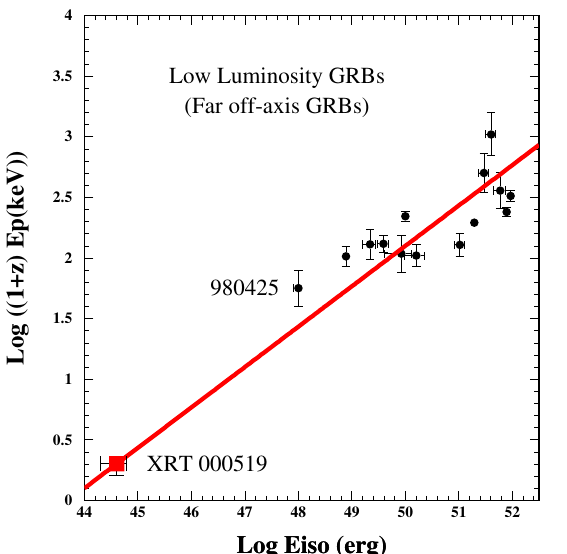
Figure 27. The [ E p , E iso ] correlation in LGRBs viewed far off axis (which include low-luminosity LGRBs and XRFs), with the addition of XRT 000519 [77] (full red square). The line is the CB model predicted correlation, Equation